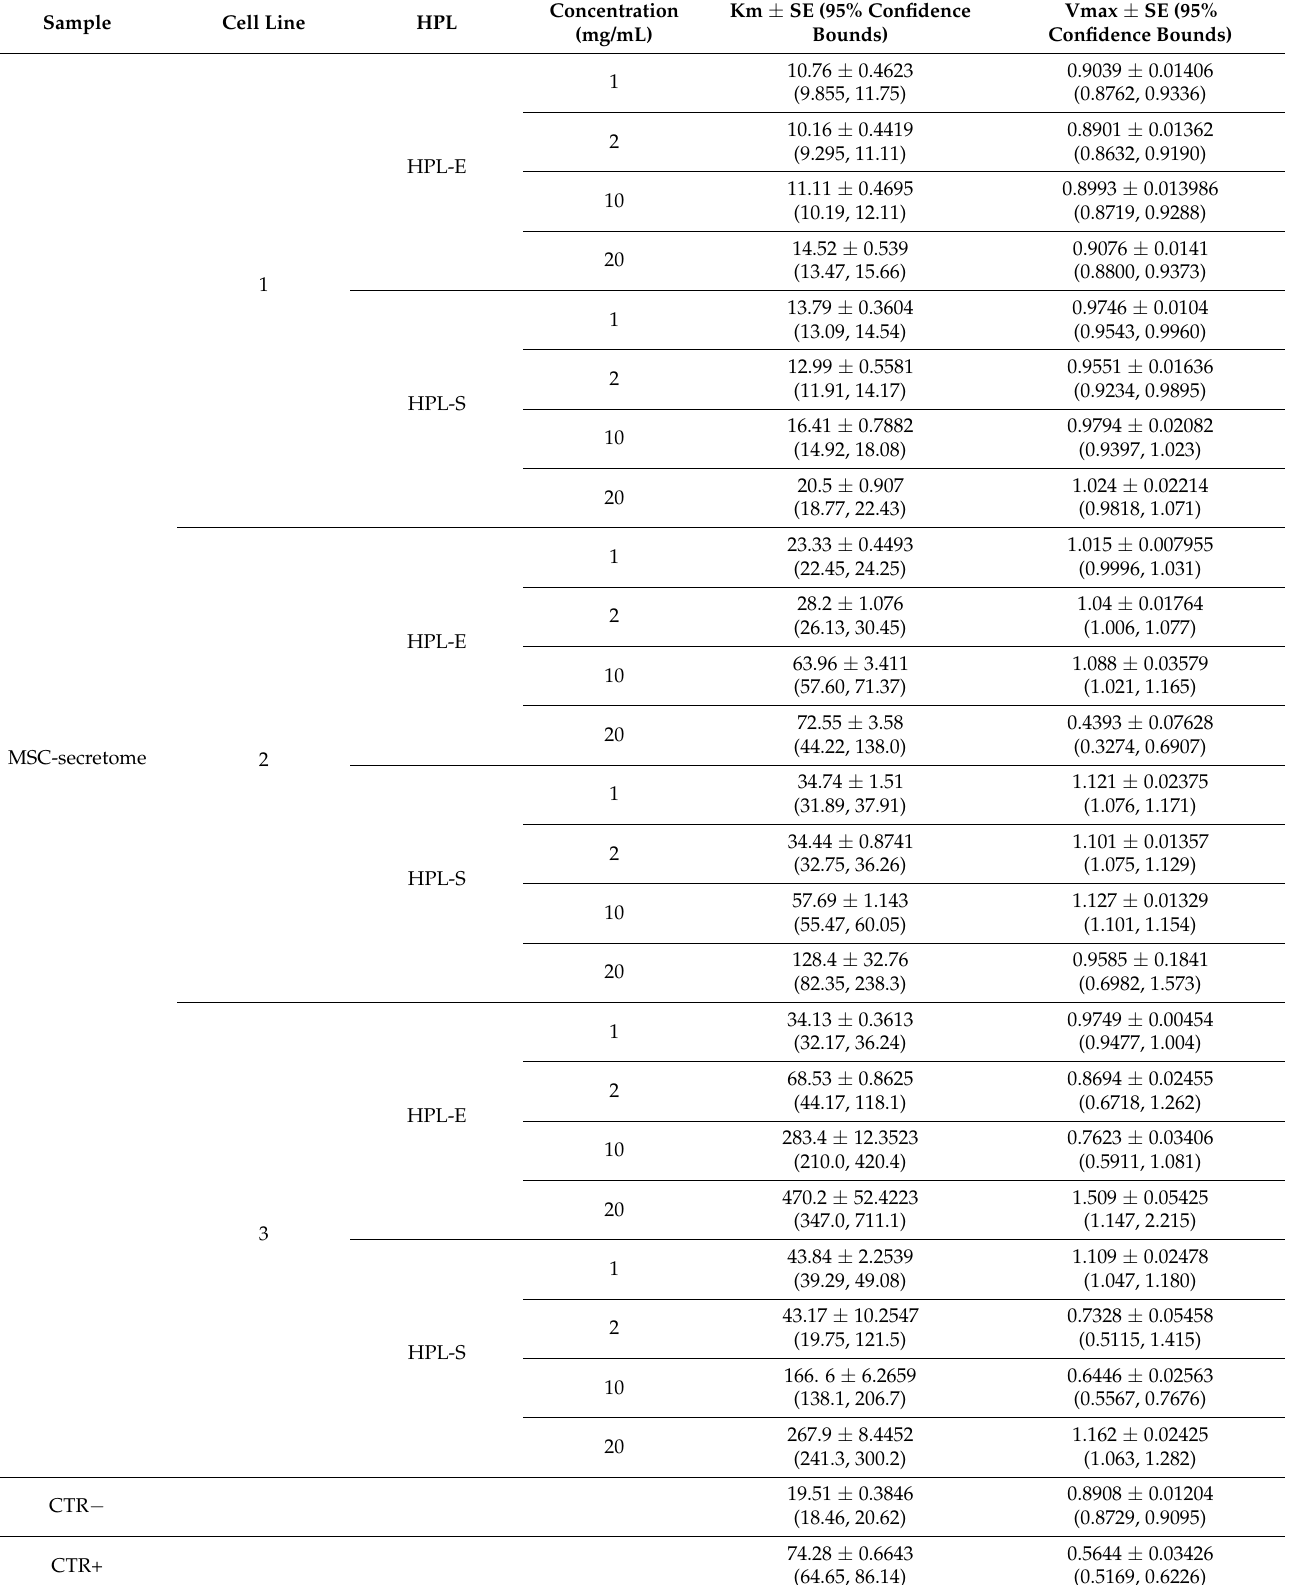
Table 2. Vmax and Km values for each sample were analyzed. Multifactor ANOVA, mean values ± LSD, n =